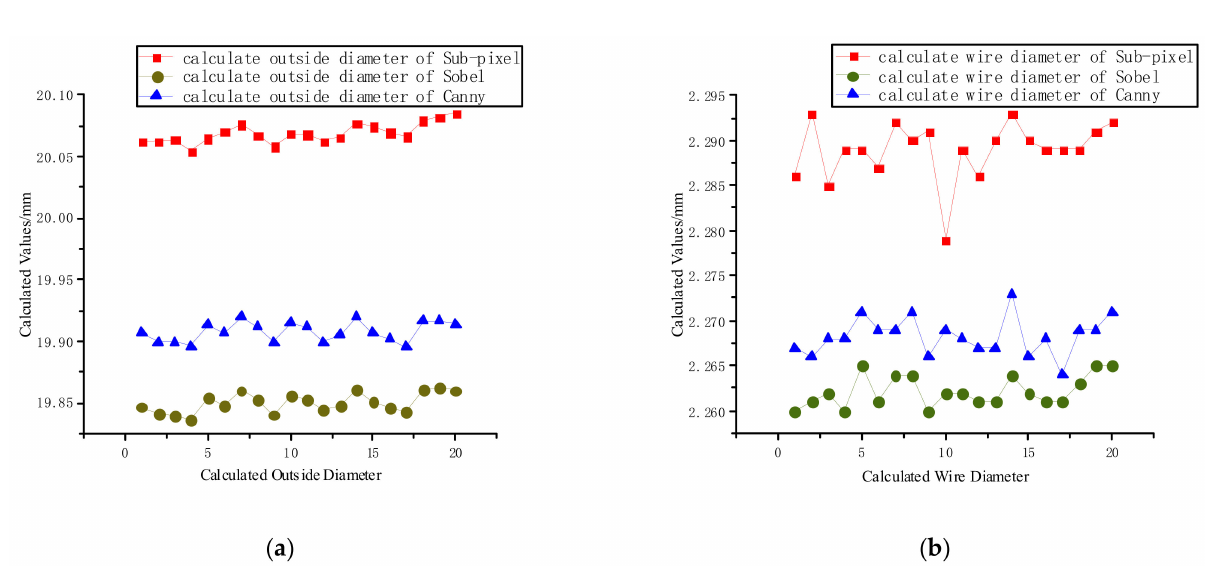
Figure 11. Graph of measurement results. ( a ) Comparison of outside diameter measurement values; ( b ) comparison of wire diameter measurement